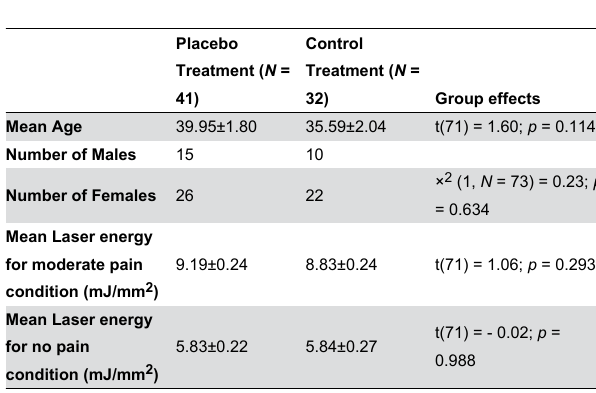
Table 1. Baseline characteristics of the